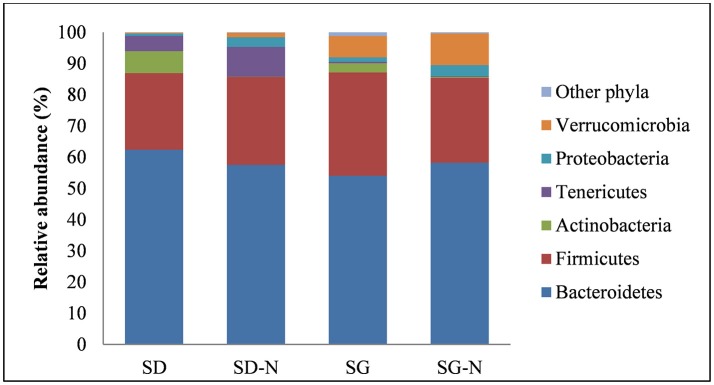
Relative abundance at phylum level with respect to each diet. Diet groups are as follows: starch dough (SD), starch dough containing nisin (SD-N), starch gel (SG), and starch gel containing nisin (SG-N) diet (n = 10).